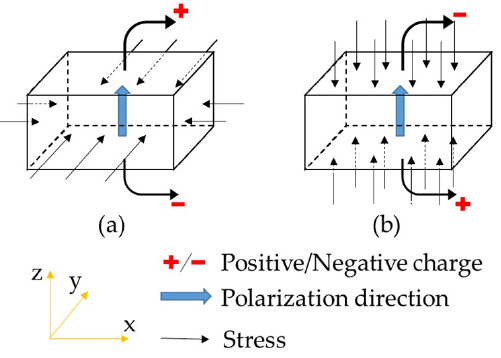
Figure 2. Working modes of the piezoelectric materials: ( a ) 3-1 mode; ( b ) 3-3 mode.